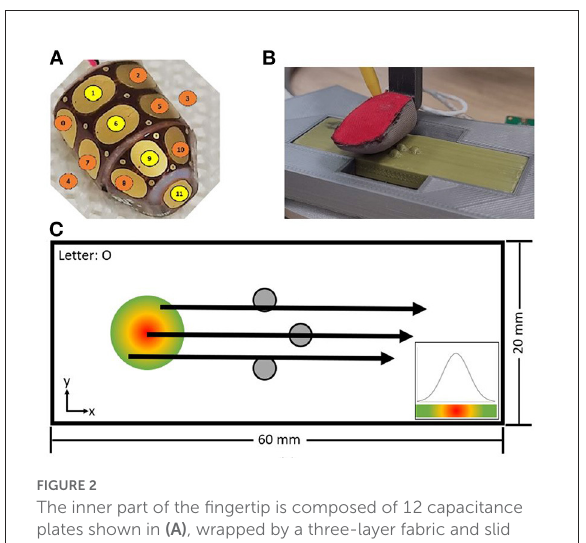
FIGURE2 The inner part of the fingertip is composed of 12 capacitance plates shown in (A) , wrapped by a three-layer fabric and slid over the Braille letters with a constant sliding distance and velocity (B) . The start position was varied following a Gaussian distribution (C)